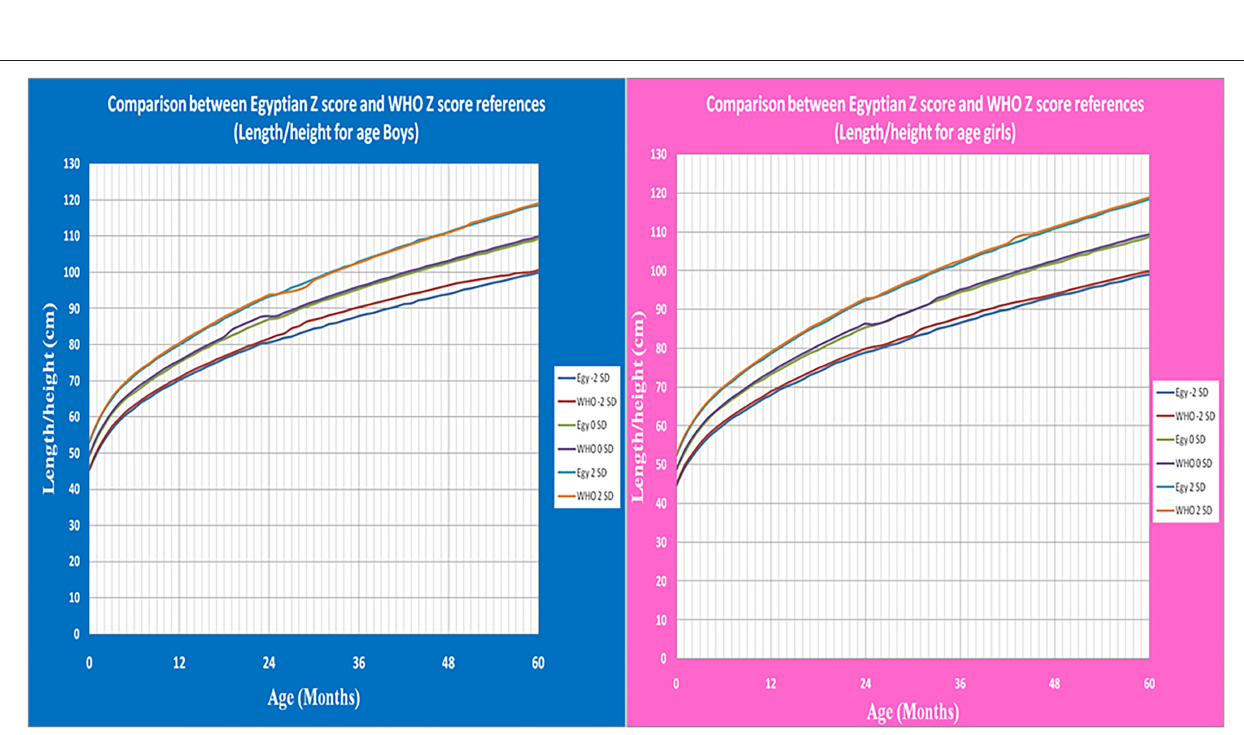
Frontiers in Pediatrics |